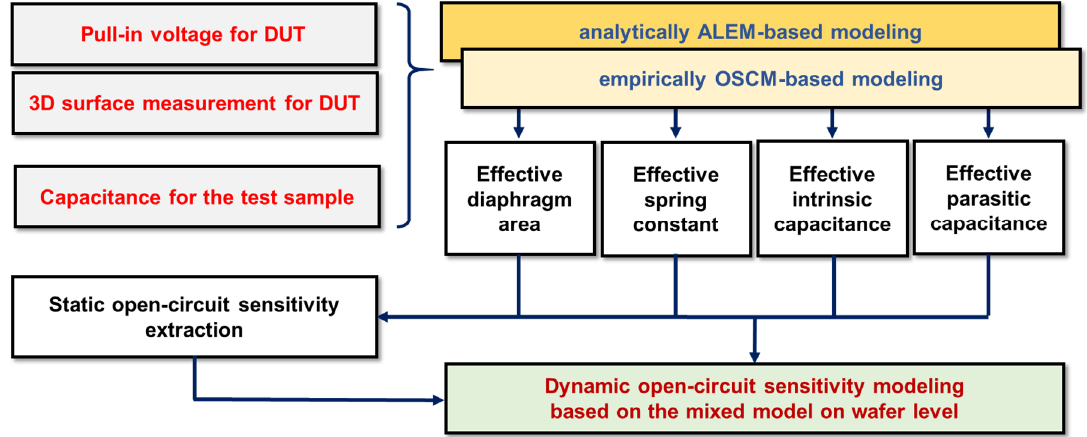
Figure 5. Flowchart for modeling dynamic open circuit sensitivity at the wafer level of capacitive MEMS acoustic sensors based on the ALEM and OSCM models.